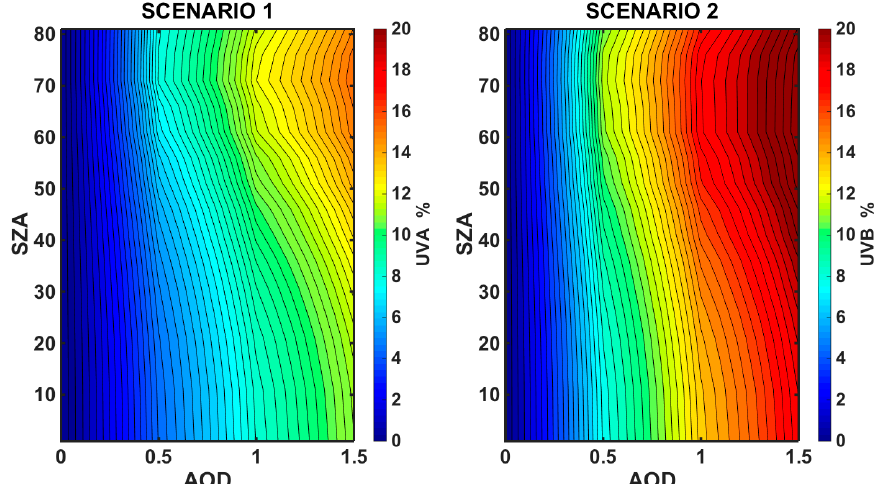
Figure 3. Relative differences of UVA ( left ) and UVB ( right ) irradiances for different SSAs as a function of SZA and AOD, calculated from RTM. Scenarios are calculated using mean SSA values at 332, 368, and 440 nm for Athens’ dataset. Scenario 1 is calculated with (SSA 440 − SSA 368 )/SSA 440 and scenario 2 with (SSA 440 − SSA 332 )/SSA 440 . Mean values for these are SSA 440 = 0.91 SSA 368 = 0.86 and SSA 332 = 0.84.